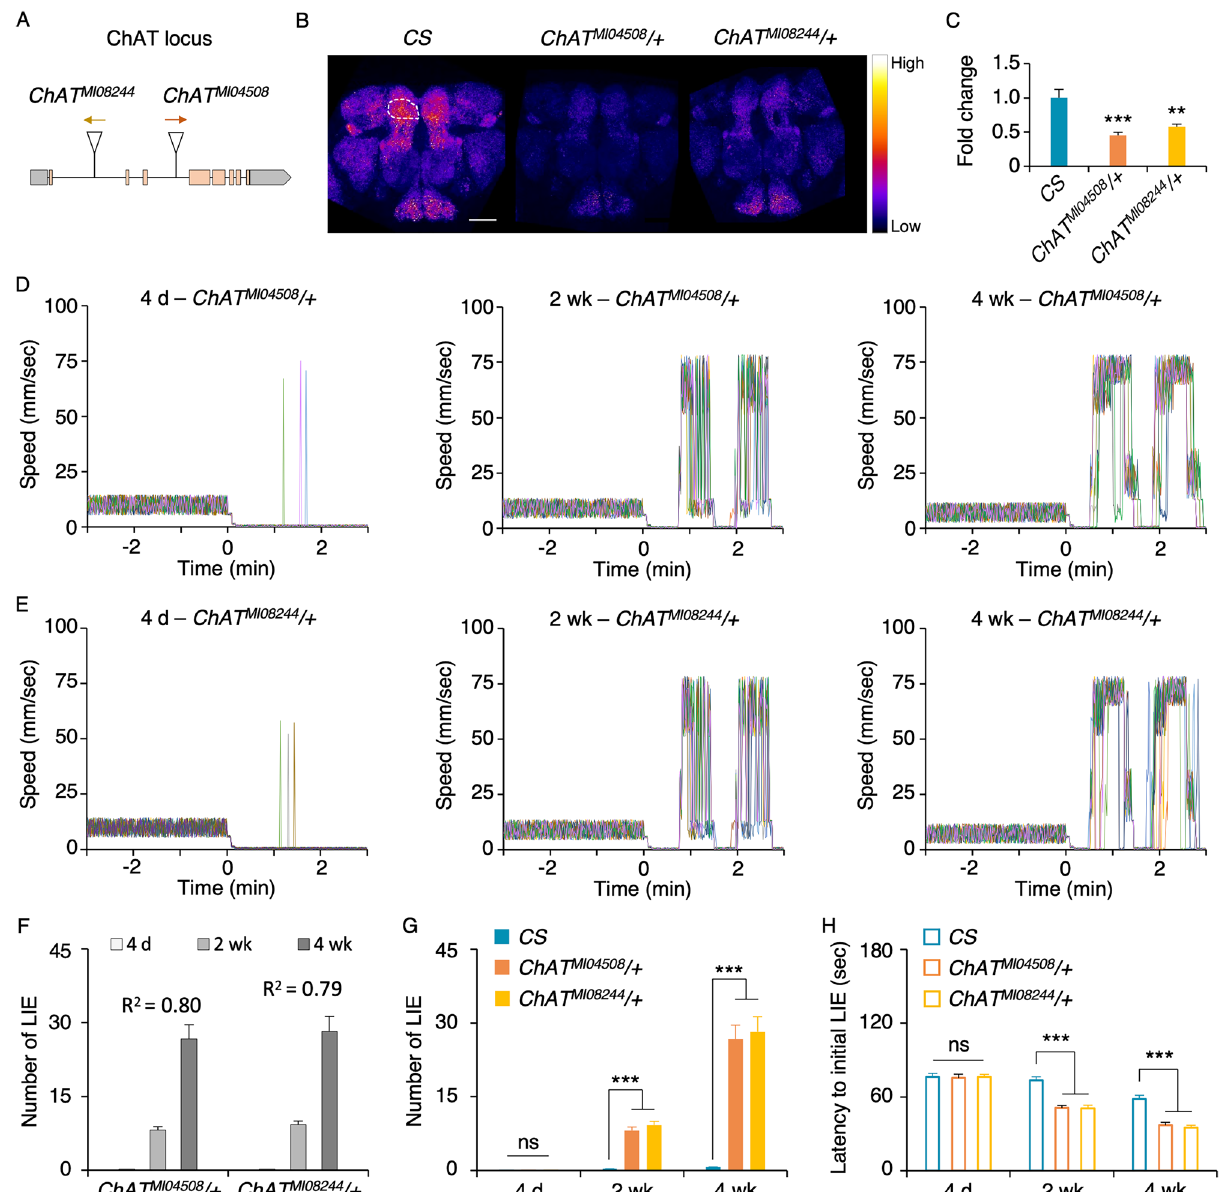
Figure 2. ChAT deficit amplifies the impaired inhibitory control with aging. (A ) The scheme depicts the locations of the transposon MiMIC insertions in the ChAT locus: ChAT MI04508 (the orange arrow denoting direction of the splice acceptor in the transposon) and ChAT MI08244 (yellow arrow denoting direction of the splice acceptor). The coding regions are noted in orange boxes, noncoding regions in gray boxes, and introns in gray lines (not to scale). ( B )ChAT immunoreactivity in the brains of CS, ChAT MI04508 / + and ChAT MI08244 / + . Signal intensity is converted into a fire scale. Quantification of ChAT immunoreactivity was done in the superior medial protocerebrum (SMP) in both hemispheres, one of which is demarcated with a white circle. Both heterozygous ChAT mutants had less ChAT immunoreactivity compared to CS . Scale bar, 50 μm. ( C ) Quantified ChAT immunoreactivity comparison. ChAT immunoreactivity levels were normalized with the average ChAT immunoreactivity level of CS . The heterozygous ChAT mutants showed significantly reduced ChAT immunoreactivity in the SMP compared to CS (ANOVA with post hoc Dunnett test using CS as a control: **, p = 0.0006; ***, p < 0.0001; n = 8–11). (D,E ) Each graph depicts the representative movement traces of 13 flies in a chamber: ChAT MI04508 / + ( D ) and ChAT MI08244 / + ( E ) across different ages (4 day, 2 week, and 4 week). ( F,G ) Comparison of the number of LIEs per fly per min for ChAT MI04508 / + , ChAT MI08244 / + and CS at three different ages. The older heterozygous ChAT mutants exhibited higher LIEs ( F : ANOVA R 2 values are noted in the graph; n = 12), which are significantly more than those of CS at the ages of 2 week and 4 week but not at the age of 4 day ( G: ANOVA with post hoc Dunnett test using CS as a control: ns, p > 0.05; ***, p < 0.0001; n = 12). ( H ) Latency to initial LIE. ANOVA with post hoc Dunnett using CS as a control: ns, p > 0.05; ***, p < 0.0001; n = 12). The heterozygous ChAT mutation caused significantly earlier onset of LIE at the ages of 2 week and 4